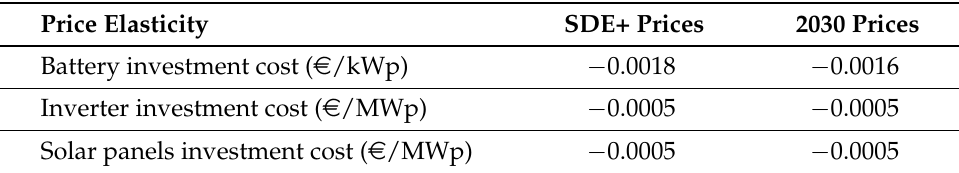
Table 1. Price elasticity of selected